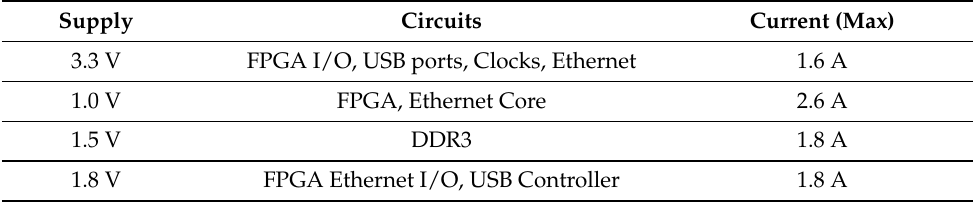
Table 4. PYNQZ1 power supplies